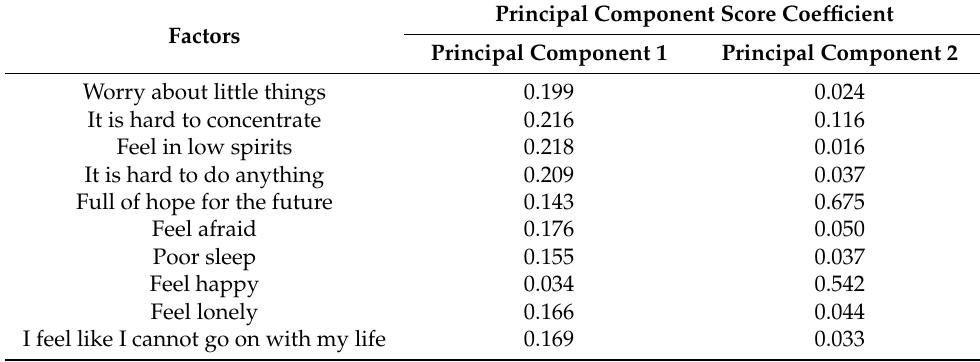
Table 2. Principal component score coefficient